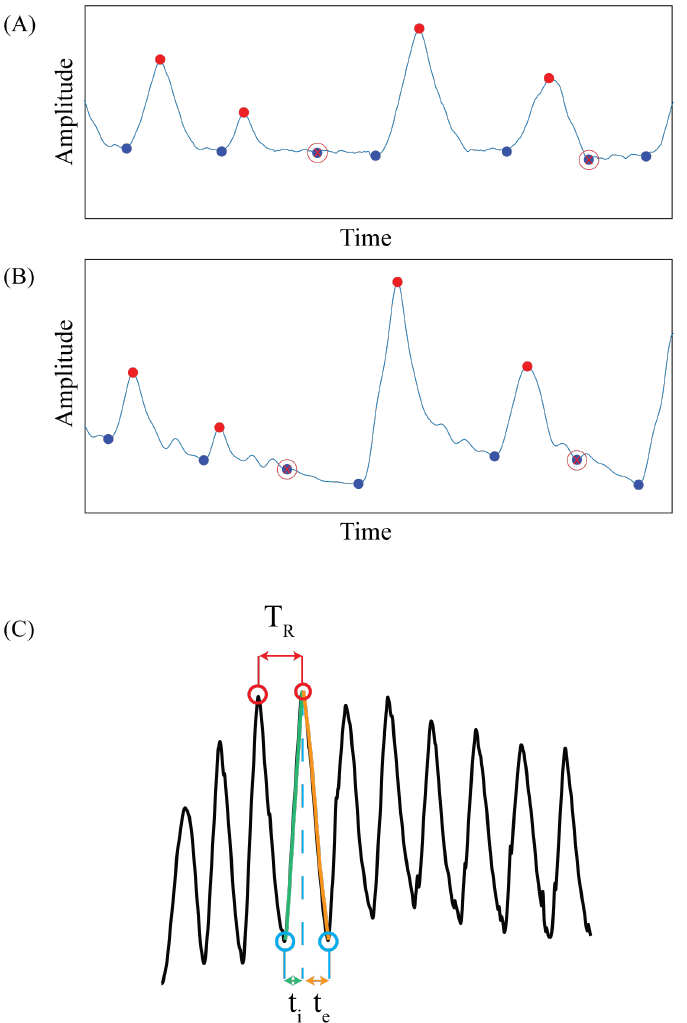
Figure 5. Example of peak misdetection performed by the algorithm on mocap signal ( A ), and on the wearable device ( B ). The maximum peaks are highlighted with the red dots and the minima peaks are highlighted with the blue dots.The misdetected peaks are highlighted by the circled red x. ( C ) shows the identification of the respiratory period ( T R ) from which the f r has been calculated, the inspiratory time ( t i ), and the expiratory time ( t e ) on the respiratory